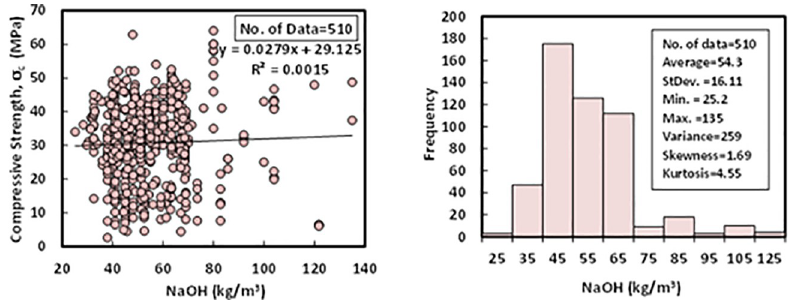
Fig 7. Variation between compressive strength and sodium hydroxide content with a histogram of fly ash-based geopolymer concrete mixtures.